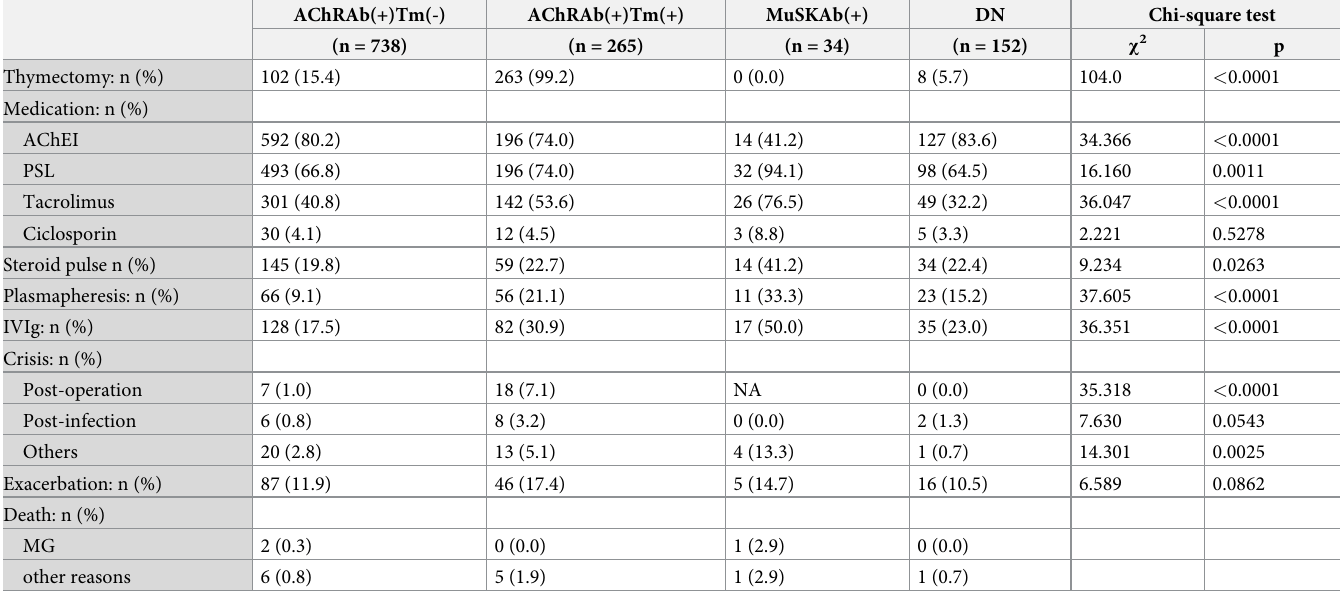
Table 7. Therapies and outcome by categories.